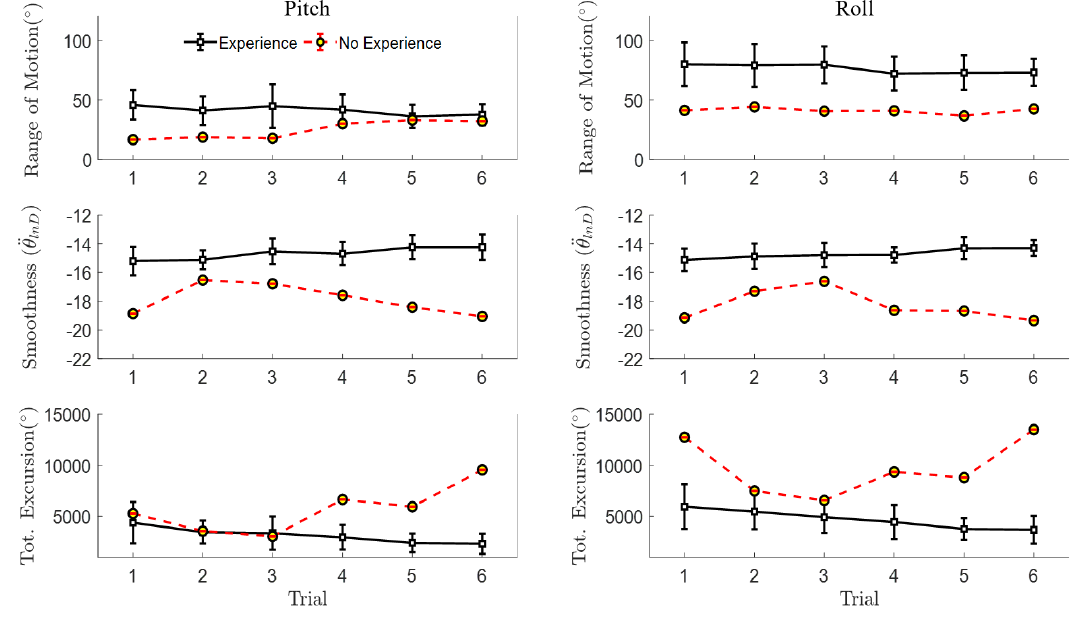
Figure 10. Quality of movement metrics across six repeated trials for a single participant with no video-game experience compared to the mean ± SD across the participants with video-game experience.